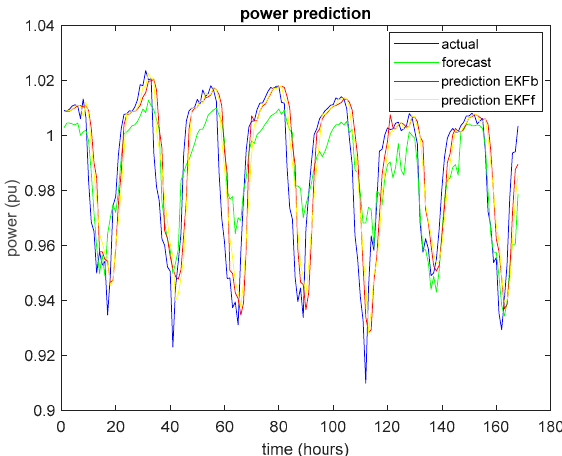
Figure 4. Power generation prediction with the Extended Kalman Filter (EKF) using the nonlinear model.